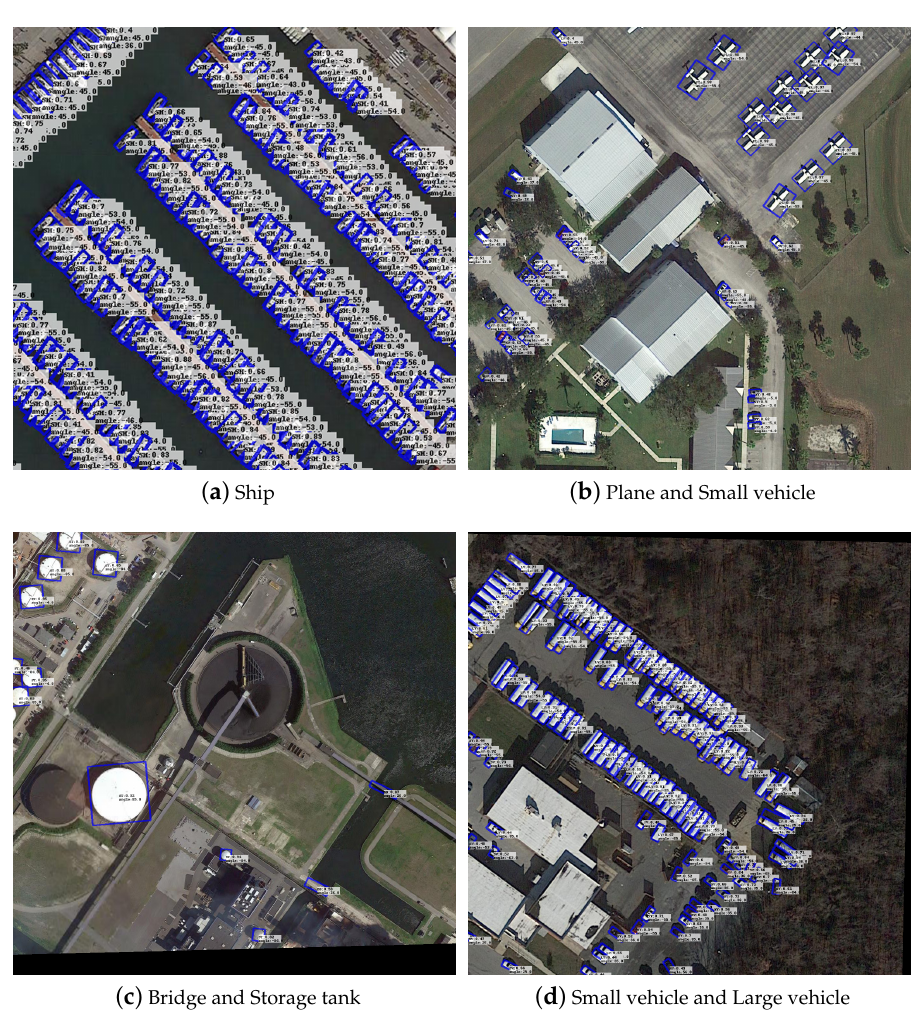
Figure 8. Visual detection results of some typical objects based on the proposed classification method.